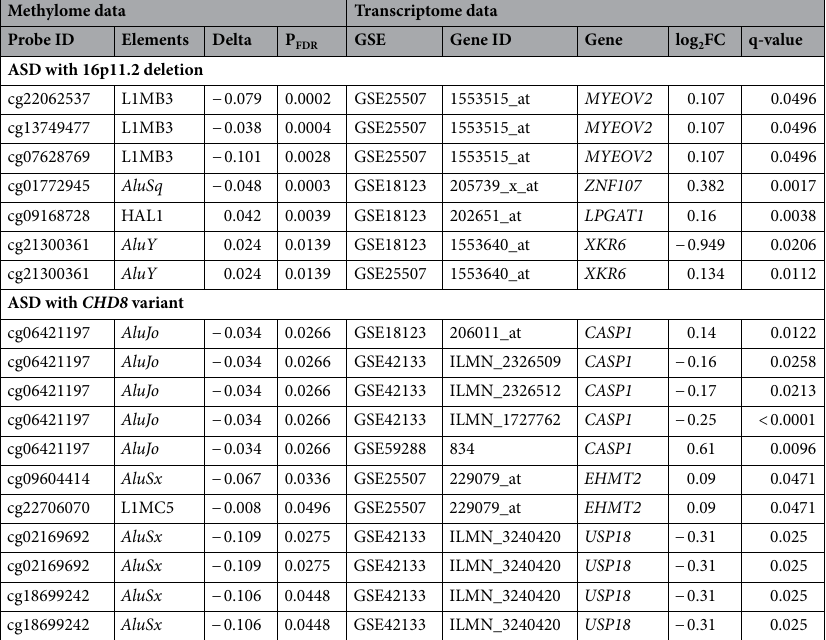
Table 2. Utilized gene expression microarrays/RNA-sequencing for the differential gene expression analysis of the target genes of ASD with 16p11.2 deletion and CHD8